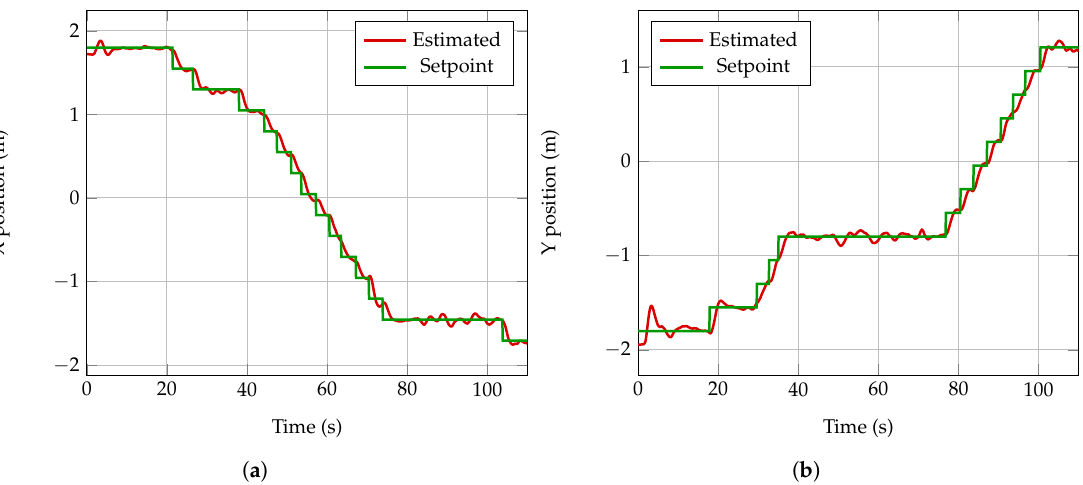
Figure A2. UAV position response for a noisy traversed path for ( a ) x and ( b ) y